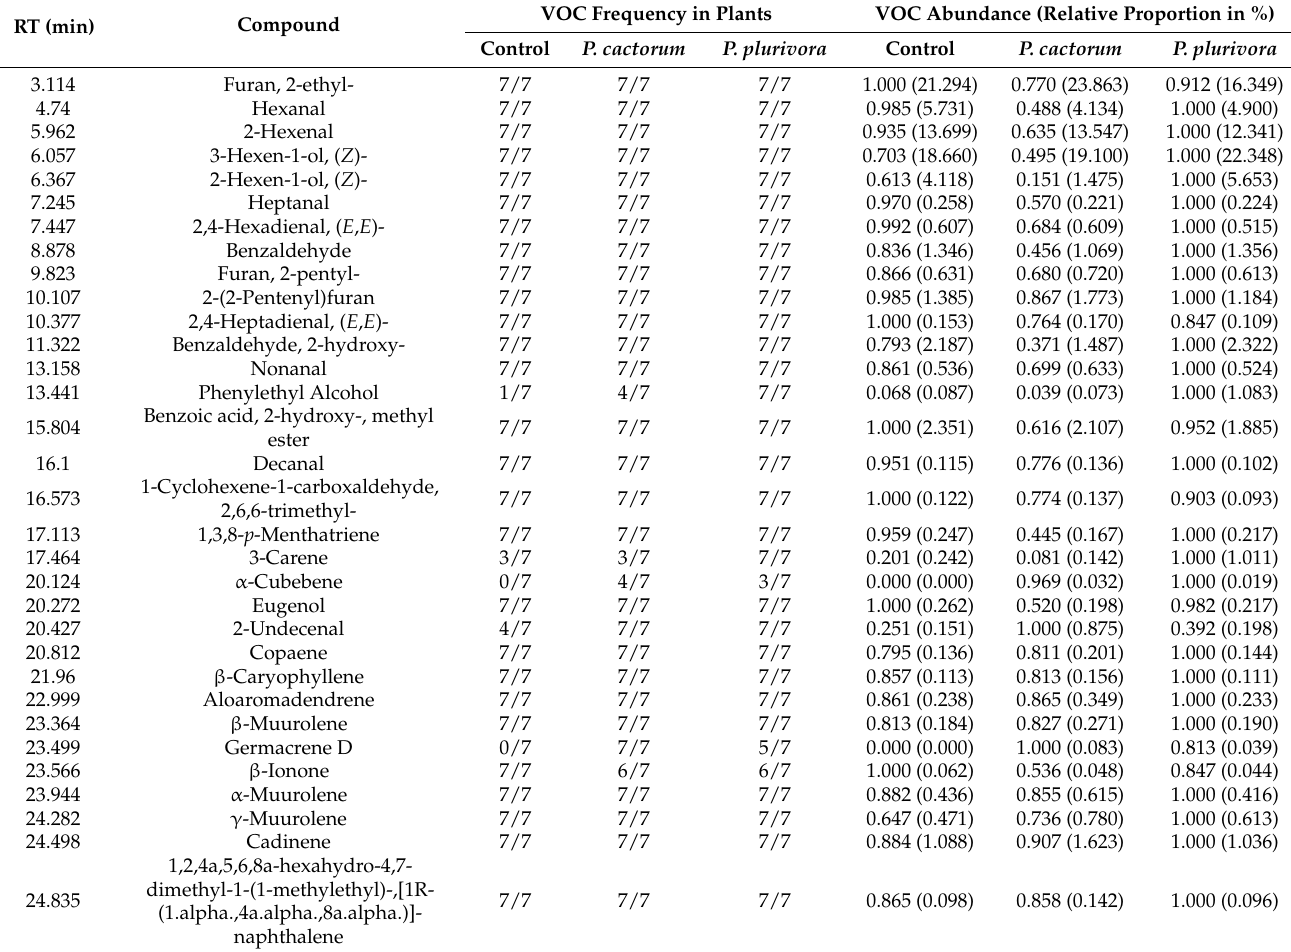
Table 3. Leaf volatile organic compounds (VOCs) identified in hybrid poplar at day 98 post-inoculation. VOC abundance values are expressed as a ratio to the maximum value for the particular compound across each row. RT, retention